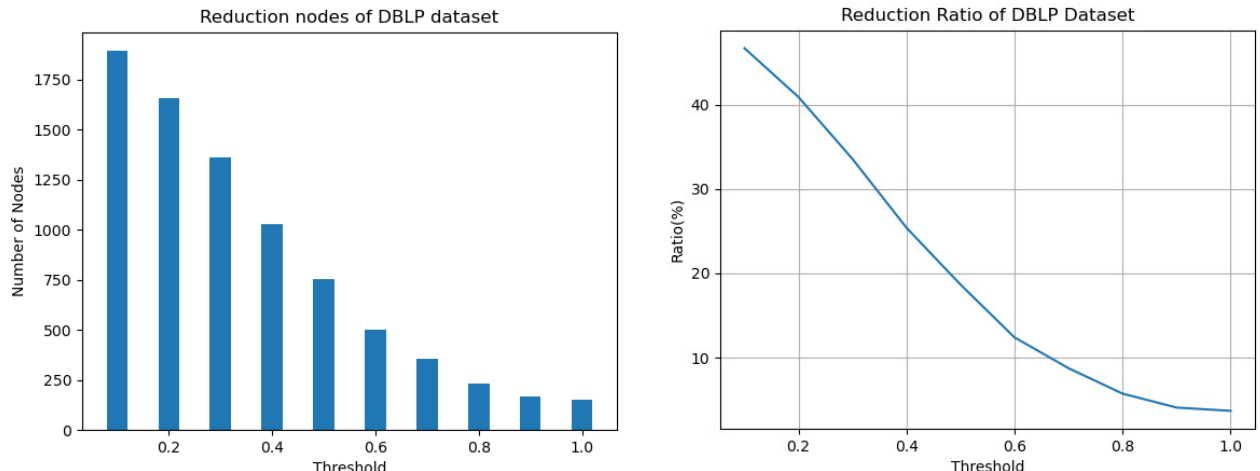
Figure 5. Histogram of the number of nodes reduced by trace equivalence ( Left ) and trend of the ratio of reduced nodes to total nodes ( Right ) on DBLP